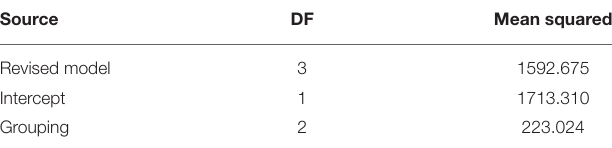
TABLE 4 | Covariance analysis